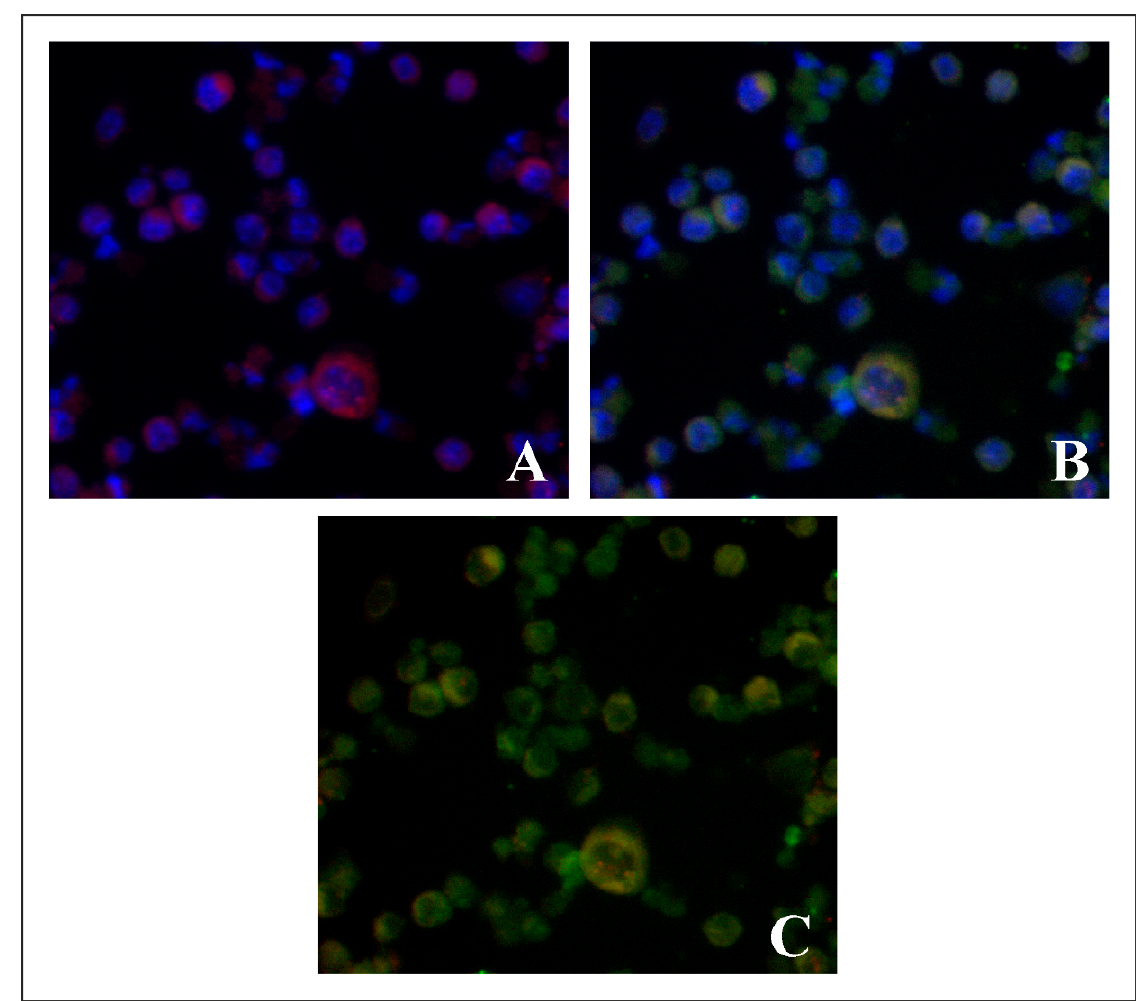
Figure 9. Fluorescent microscopic images showing colocalization of lysosomal markers LAMP1 and BODIPY 1 in Ehrlich ascitic carcinoma cells: ( A )—BODIPY 1 (red) and nuclei (blue), ( B )—LAMP1 (green) and nuclei (blue), ( C )—overlapping BODIPY 1 and LAMP1 fluorescent staining. Magnification 40×.